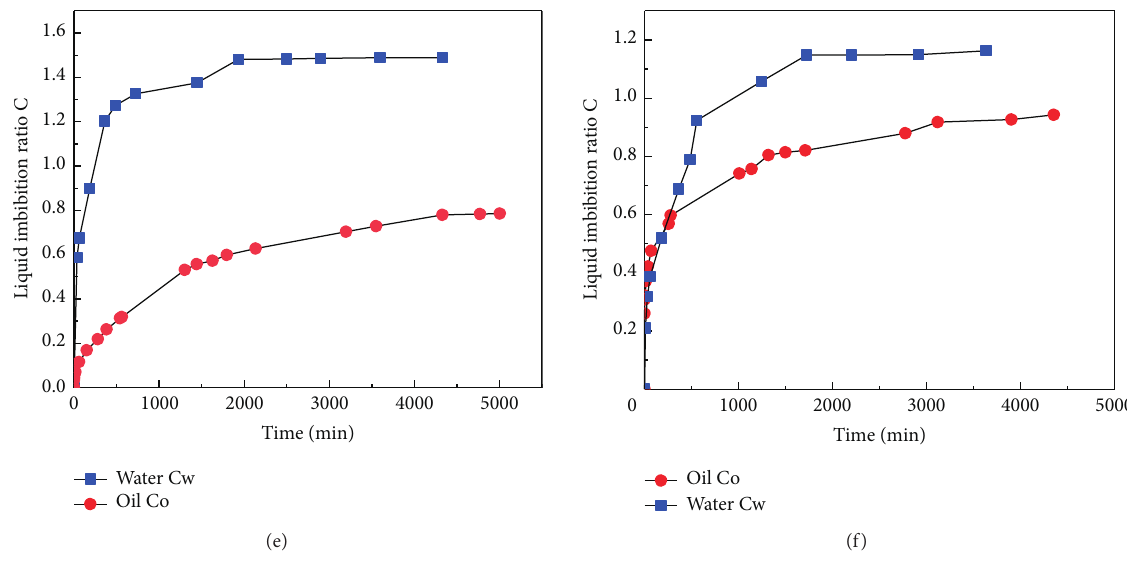
Figure 5: Differences in imbibition characteristics of n-dodecane and deionized water for different petrographic samples. (a) Sandy interlayer YY-72-2. (b) Low organic matter laminated siliceous shale YJ-62-3. (c) High organic matter laminated siliceous shale YA-151-1. (d) High organic matter massive siliceous shale YD-22-1. (e) Low organic matter laminated siliceous shale, YG-616-3. (f) High organic matter massive clay shale